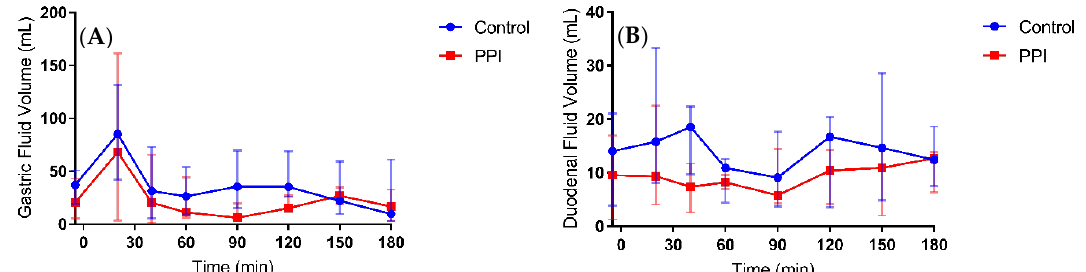
Figure 6. Median ( A ) gastric fluid volume and ( B ) duodenal fluid volume over time profiles following oral intake of a Norvir tablet with 240 mL water in control condition (blue dots) vs. PPI condition (red squares). The error bars depict range (n = 5).